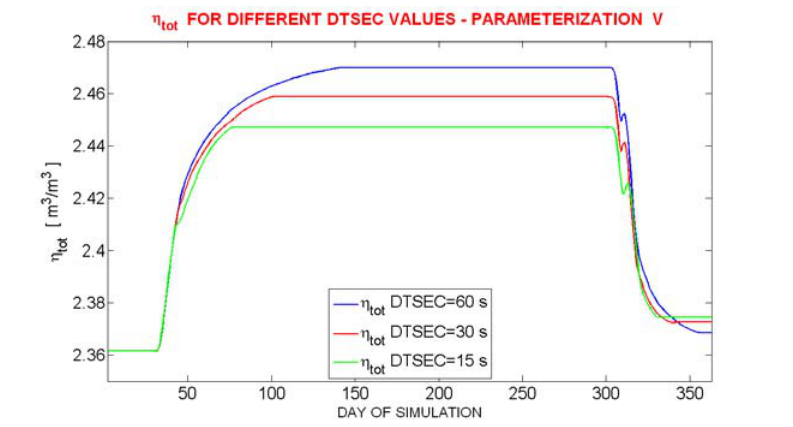
trends evaluated in the sensitivity test summarized in Figure 9. The three Figure 10. η tot simulations have been executed using three different time step (DTSEC) values. The numerical convergence toward a constant value is just slightly shown. The complete numerical convergence would have been reached shorter values of DTSEC, however this is not shown because it requires too large a computation